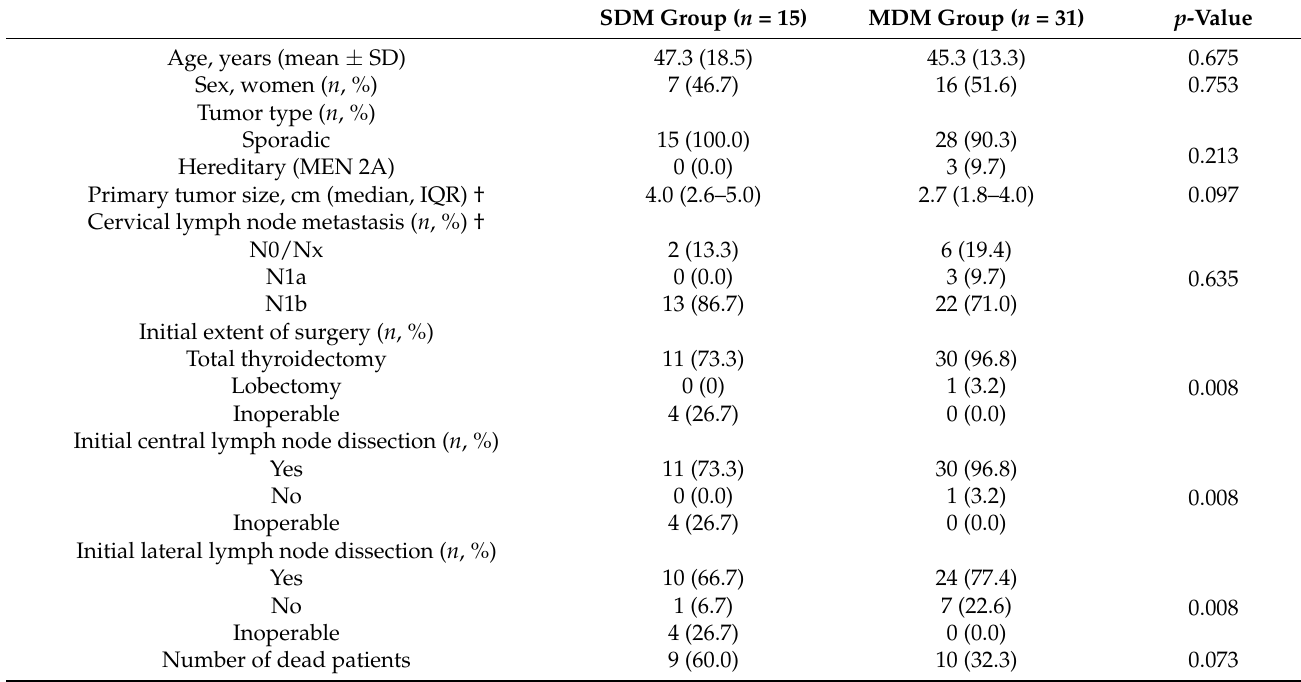
Table 2. Comparison of clinical characteristics between SDM and MDM